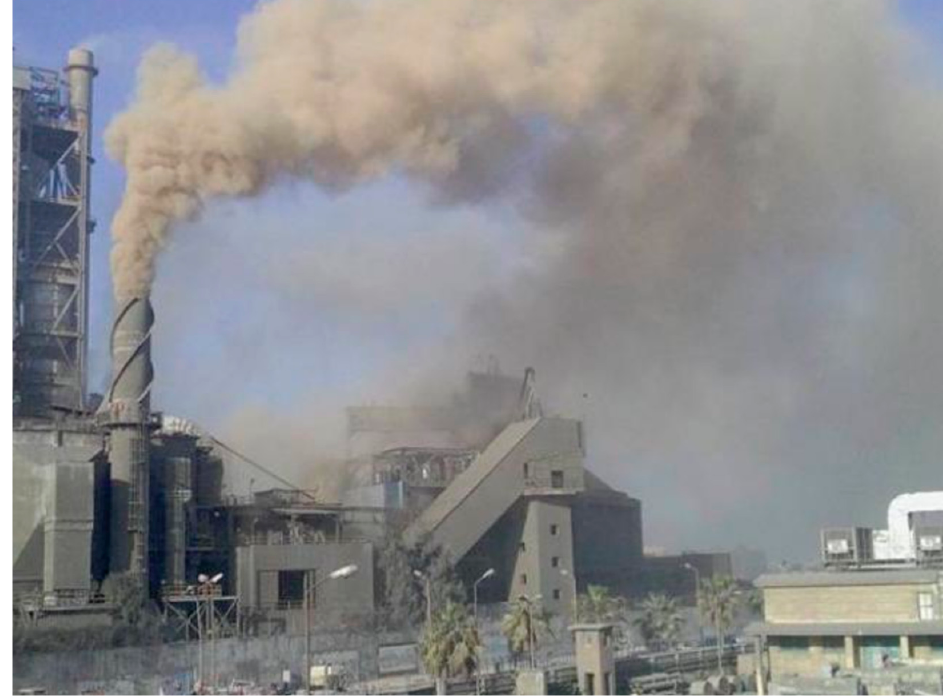
Figure 5. Pollution from cement production in Nigeria. Source: [62]. Abimbola et al. (2007) [63] evaluated past hospital documentations and the present well-being of locals and revealed the increasing contagion of sickness connected to huge alloy fatality, generated by cement dust from factories, posing a threat to future habita- tion. The research considered the quantities of selected heavy metals in Figure 6 as: soils [Ni (13.0–17 ppm), Cd (0.5–1.1 ppm), Zn (43–69 ppm), Cu (22–35 ppm), Pb (28–49 ppm)], shale [Cu (2.0–11 ppm), Pb (17–22 ppm), Cd (0.3–1.1 ppm), Ni (3.0–18 ppm), dusts [Cd (0.5–0.7 ppm), Zn (17–147 ppm)], Cu (2–16 ppm), Pb (32–52 ppm), Ni (2–17 ppm)], Zn (5–152 ppm), limestone [Cu (3.0–11 ppm), Ni (3.0–8.0 ppm), Cd (n.d.-1.7 ppm), Zn (7.0–53 ppm), and Pb (42–48 ppm)].